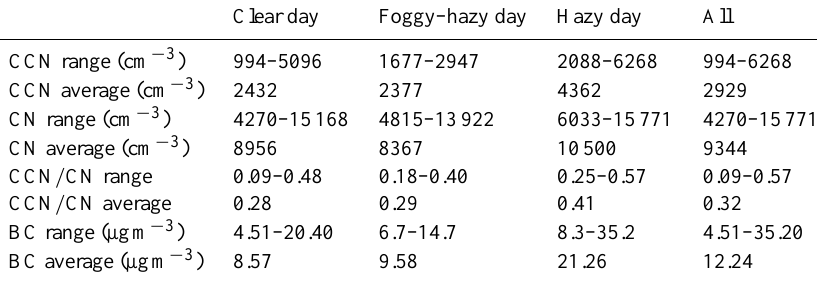
Table 2. Statistics of CCN, CN, CCN / CN and BC in different weather